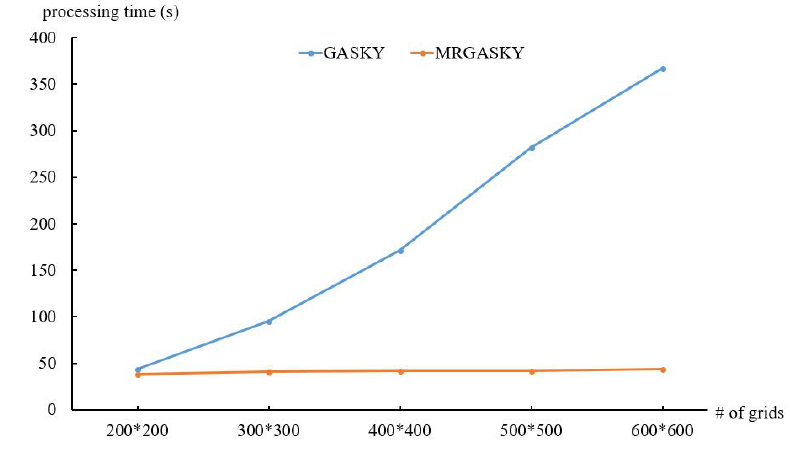
Figure 17. Processing Time of